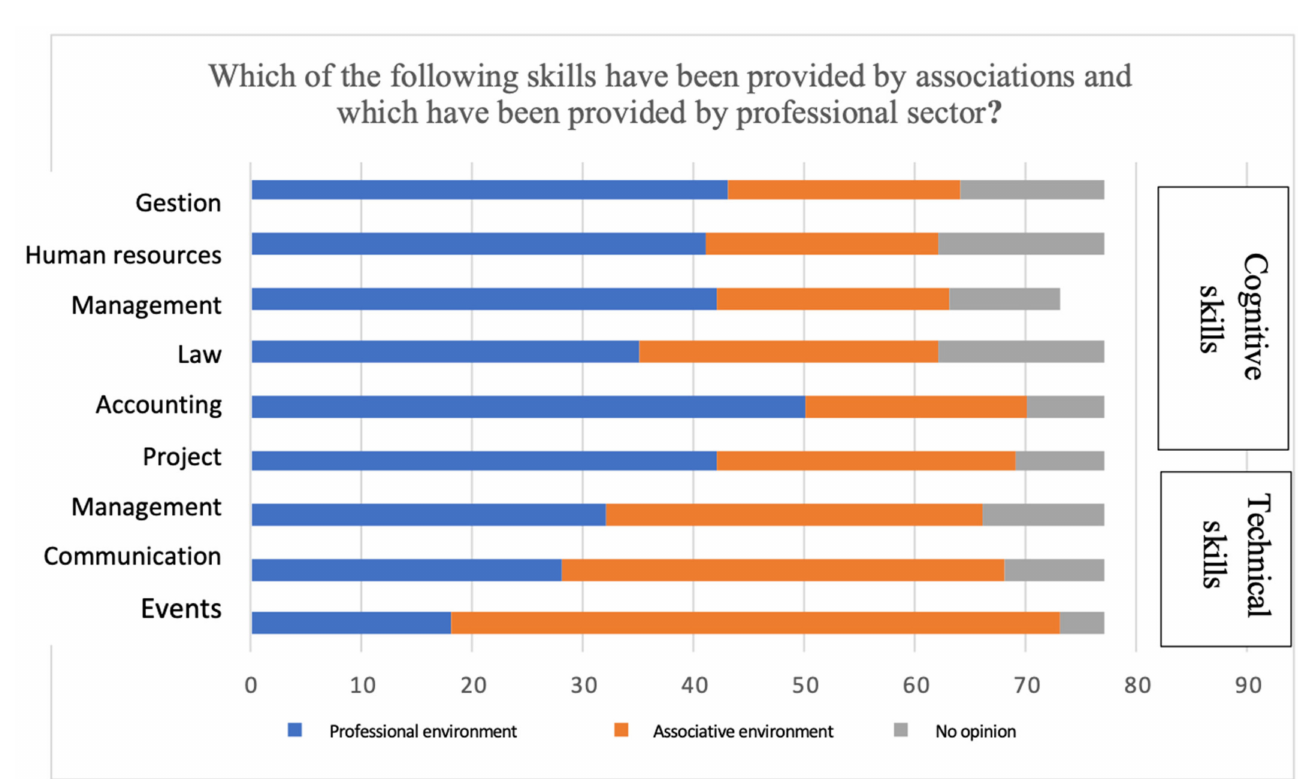
Figure 2. Source of skills mobilised by volunteers in